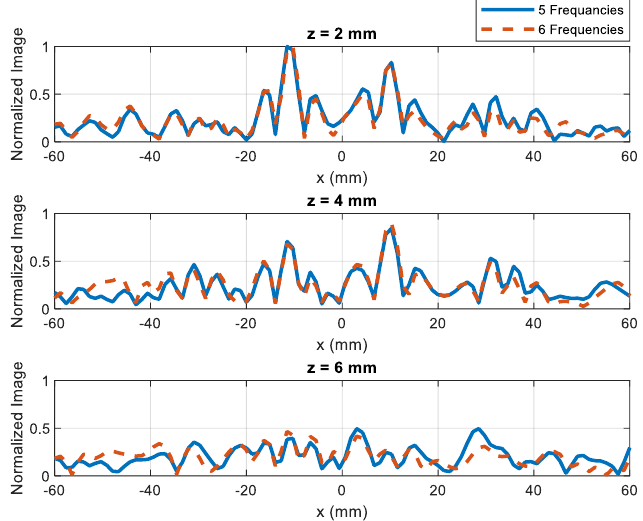
Figure 12. Reconstructed 1D images of defect with a depth of 4 mm when using 5 and 6 frequencies.